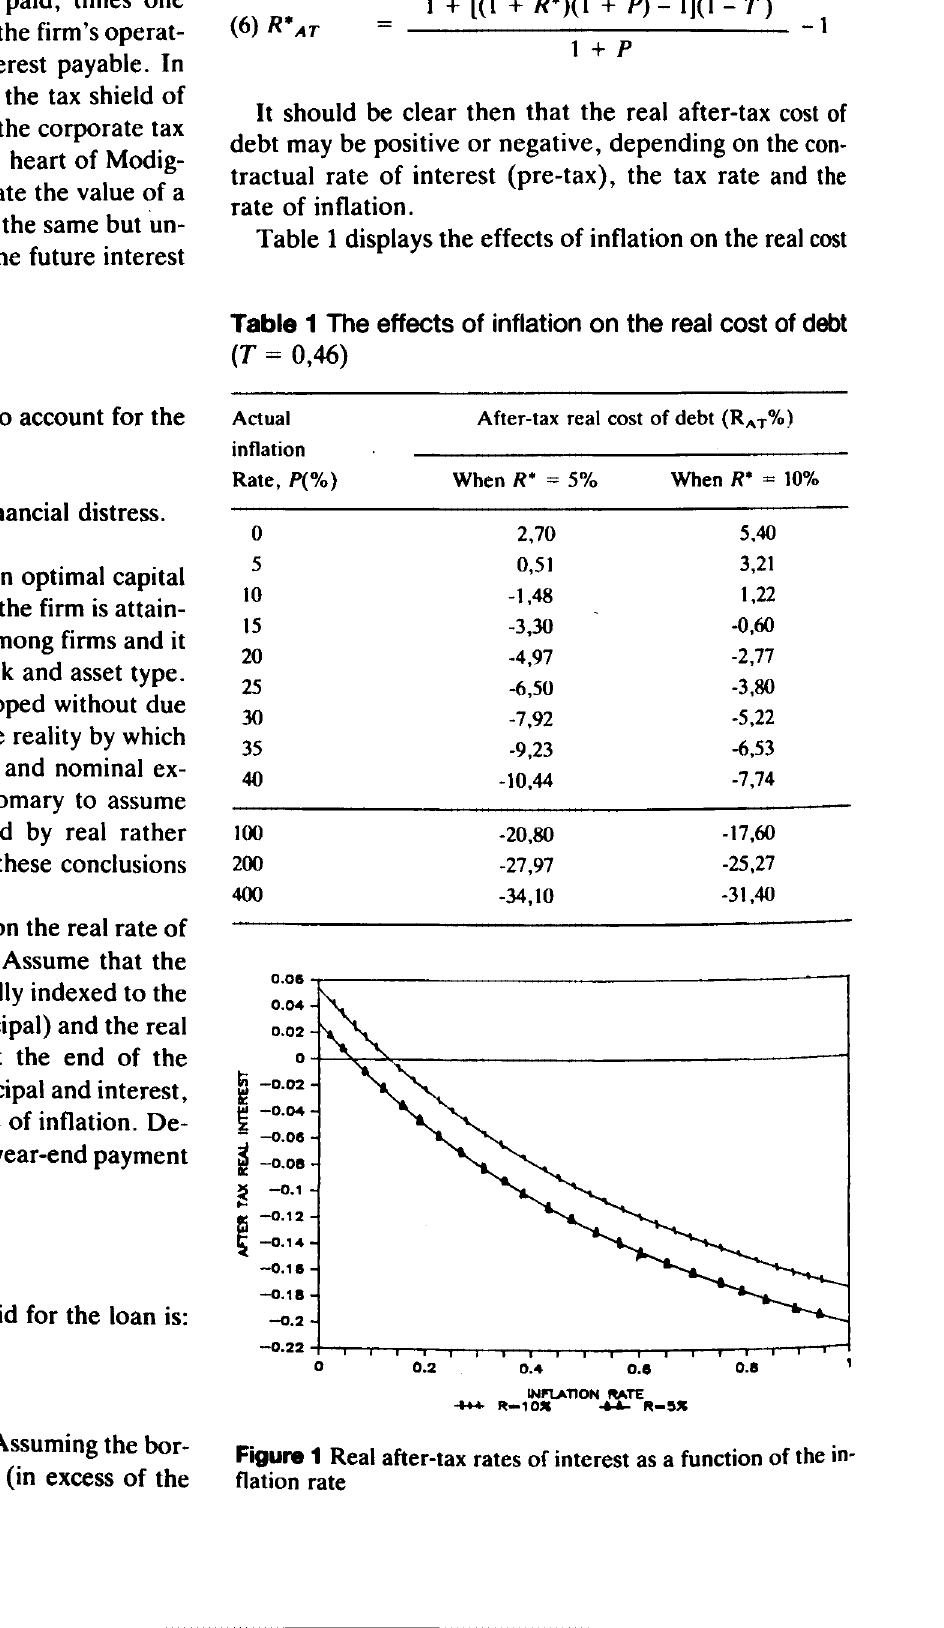
Figure 1 Real after-tax rates of interest as a function of the in· flation